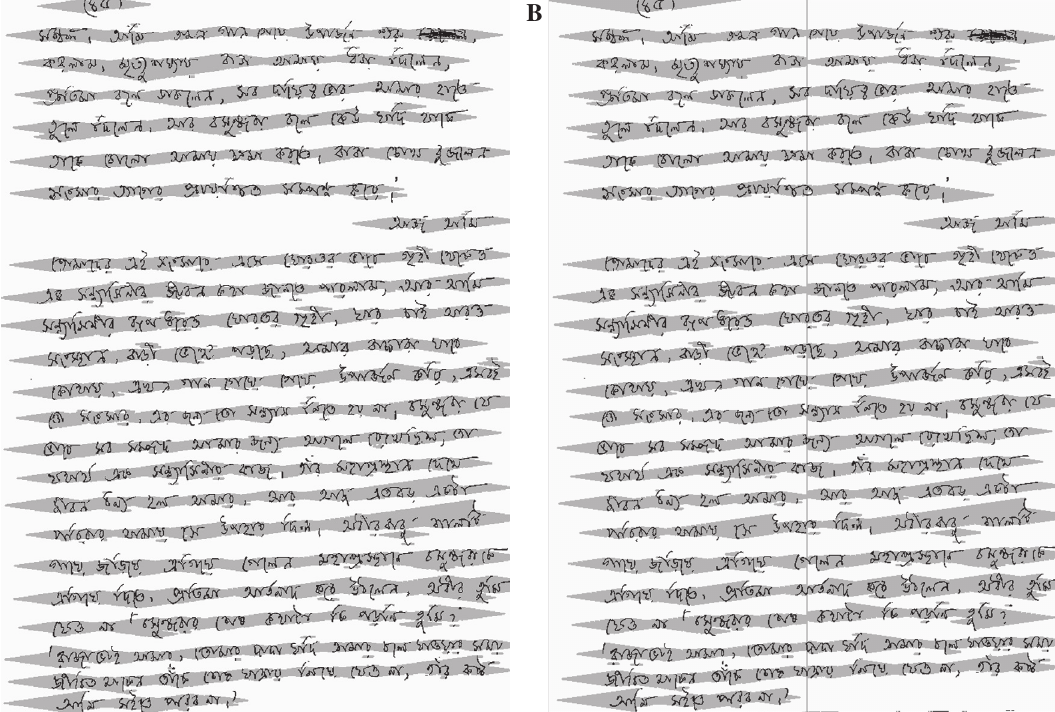
Figure 4. Hypothetical Water Flow in a Document